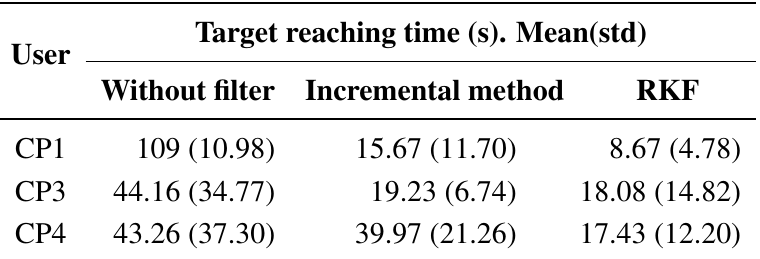
Table 7. Reaching time (seconds) for each user and